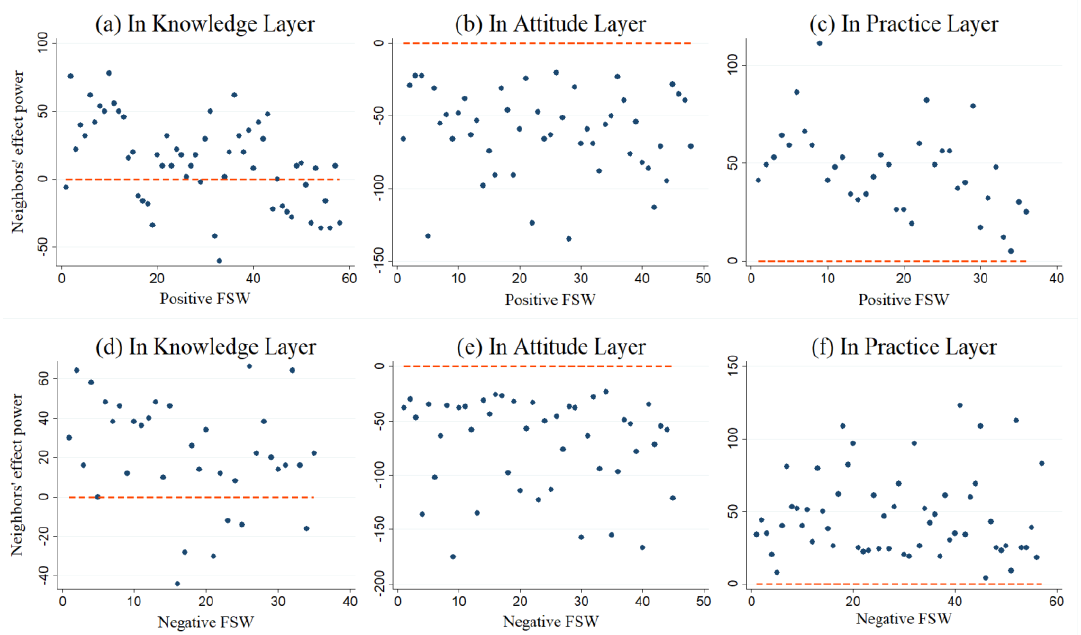
Figure 5. Positive or negative impact power from FSWs’ neighbors. The x -axes refer to the positive FSWs (a-c) or negative FSWs (d-f). The y -axes refer to their neighbors’ effect power 𝑠 𝑖[𝛼] of FSW 𝑖 . The red dashed lines in the figure are the auxiliary reference line with 𝑠 𝑖[𝛼] = 0 .